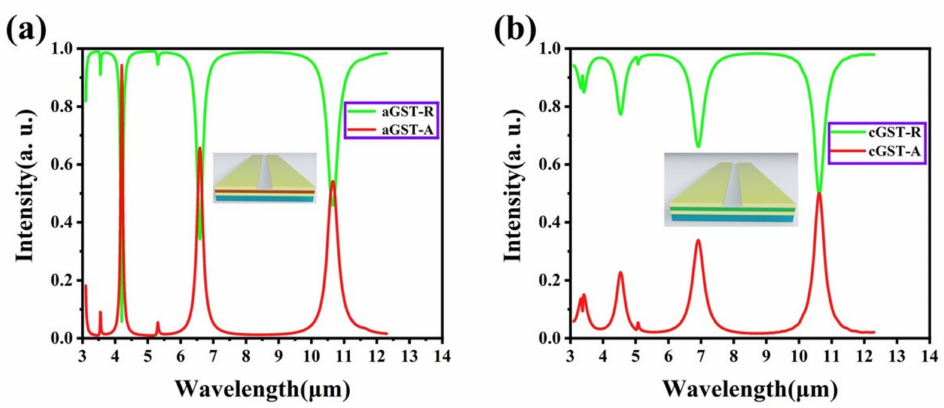
Figure 5. Absorptivity and reflectivity of the designed five-layer structure in the infrared-laser band ( a ) when the GST film is in the amorphous state and ( b ) when the GST film is in the crystalline